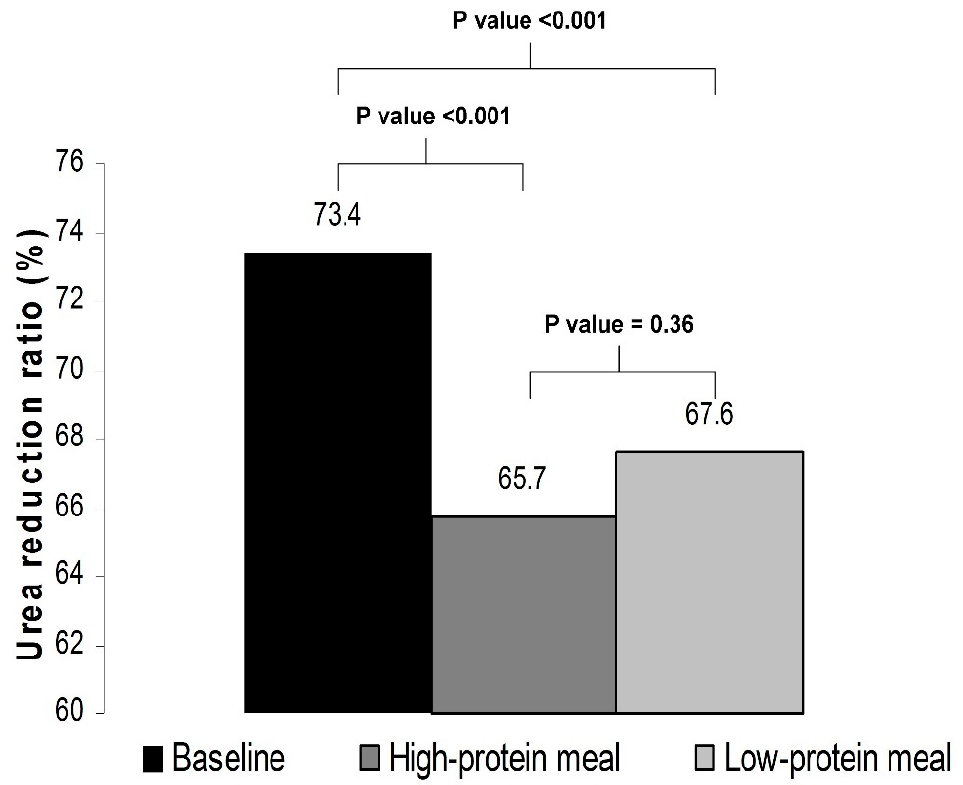
Figure 2. Urea reduction ratio at baseline and in phases A and B of the study.